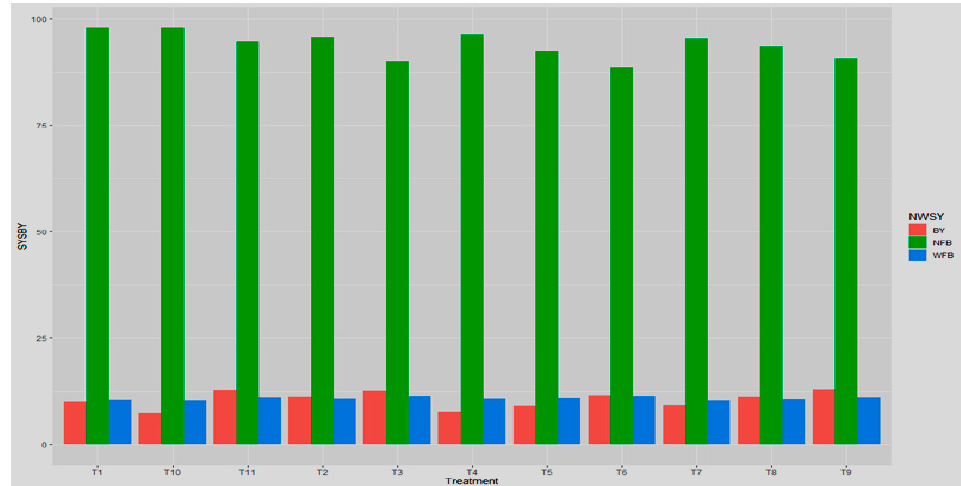
Figure 12. Comparative bar chart designates the effect of systemic fungitoxicants on T. harzianum infested casing pooled during spring 2017 and 2018 on the number and weight of fruit bodies and button yield, where T1 = Carbendazim 0.025% conc., T10 = Check I (infested-untreated), T11 = Check II (uninfested-untreated), T2 = Carbendazim 0.05% conc., T3 = Carbendazim 0.1% conc., T4 = Thiophanate methyl 0.025% conc., T5 = Thiophanate methyl 0.05% conc., T6 = Thiophanate methyl 0.1% conc., T7 = Myclobutanil 0.025% conc., T8 = Myclobutanil 0.05% conc., T9 = Myclobutanil 0.1% conc.